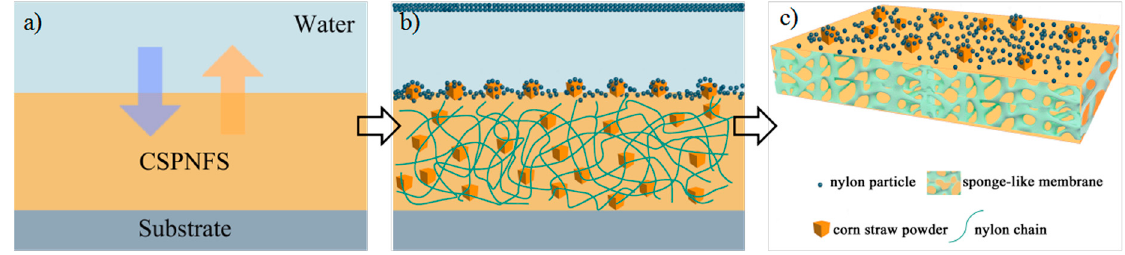
Figure 1. Formation of the CSPNM (corn straw powder-nylon 6,6 membrane) by a phase-inversion process.